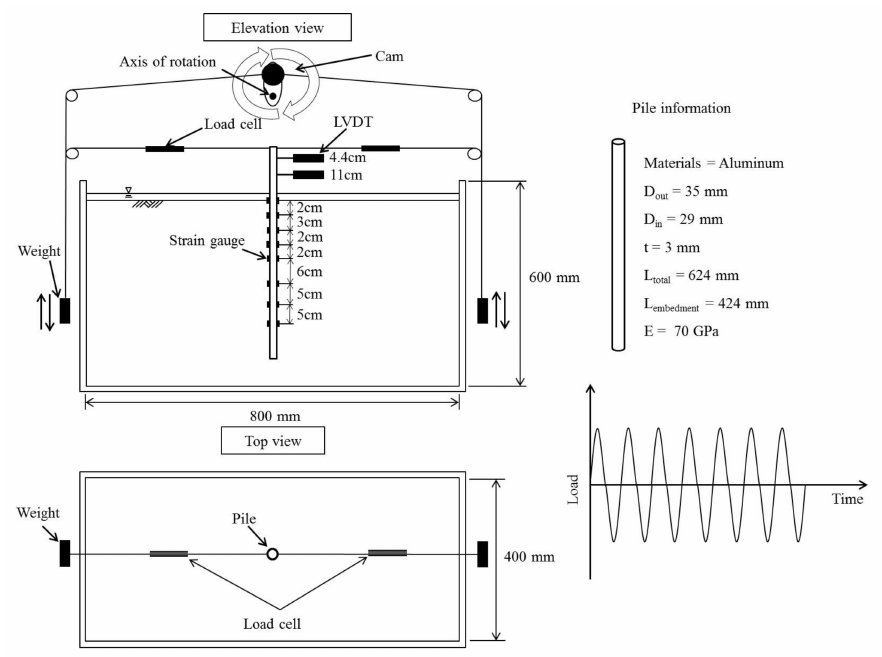
Figure 5. Cyclic loading test concept diagram and cross section diagram.